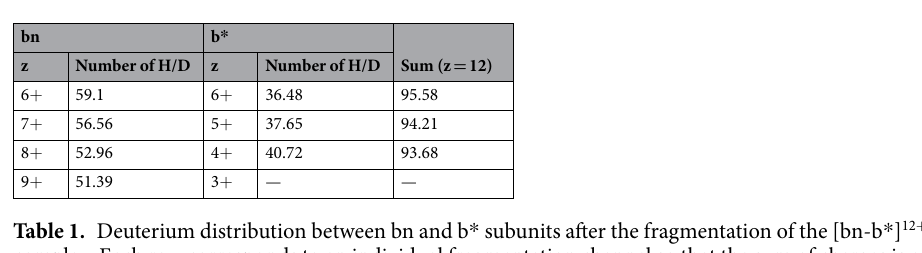
Figure 3. The tandem MS experiment. The numbers of exchanges in the parent ion and in the fragments are shown. Black numbers show the charge state for the corresponding ion shown in red. Lines: green – bn-b * complex, red – bn, black – b * , blue – b * -b * complex observed for a H 2 O:MeOH solution.